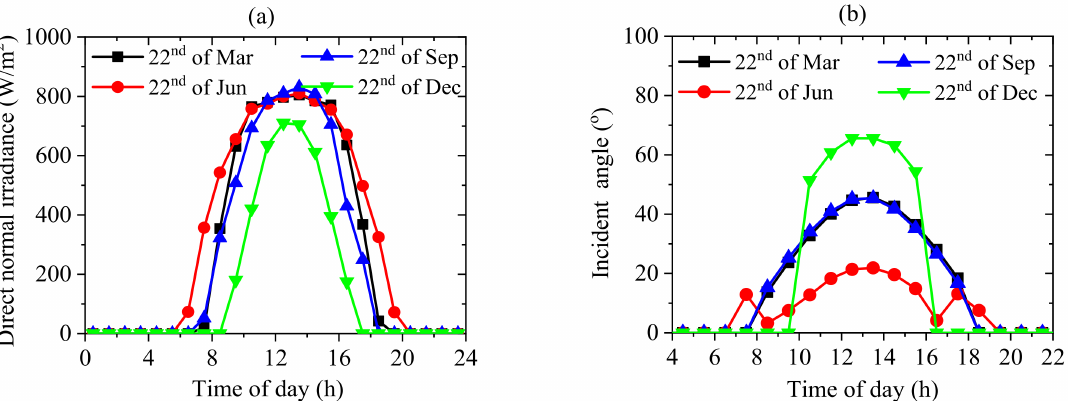
Figure 13. Daily variations of ( a ) DNI and ( b ) solar incidence angle under four different reference days.